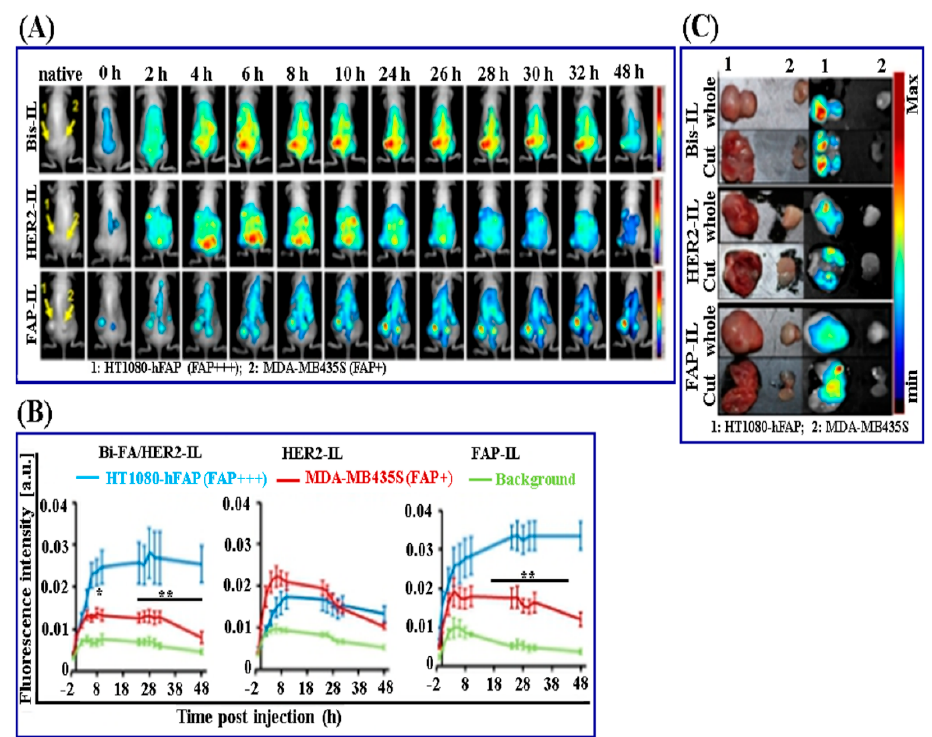
Figure 3. Illustration depicts in vivo evaluation of near-infrared fluorescent dye-loaded liposomal nanomedicine as can- cer diagnostics for the image-guided nuclear delivery of the encapsulated dye ( A ) in vivo imaging of delivery of NIR-fluorescence dye (DY676-COOH) in mice bearing FAP-expressing fibrosarcoma HT1080-hFAP [1] and FAP-expressing human melanoma MDA-MB435S [2] after i.v. injection for 0–48 h. ( B ) Semiquantitative analysis of fluo- rescence intensities of a region of interest on respective tumors or background (thigh region) at a given time point. ( C ) Photograph and NIR-fluorescence images of tumor tissue excised after the 48 h of liposomal nanomedicine (monospecific and bispecific) administration indicating intense liposomal fluorescence in case of mice bearing FAP-expressing fibro- sarcoma HT1080-hFAP. Reproduced from [94], MDPI, 2020. Note: Three groups of tumor-bearing mice were treated with two types of monospecific liposome (HER2-IL and FAP-IL) and one Bispecific liposome (Bi-FAP/HER2-IL).* significant compared to control,** highly significant compared to control